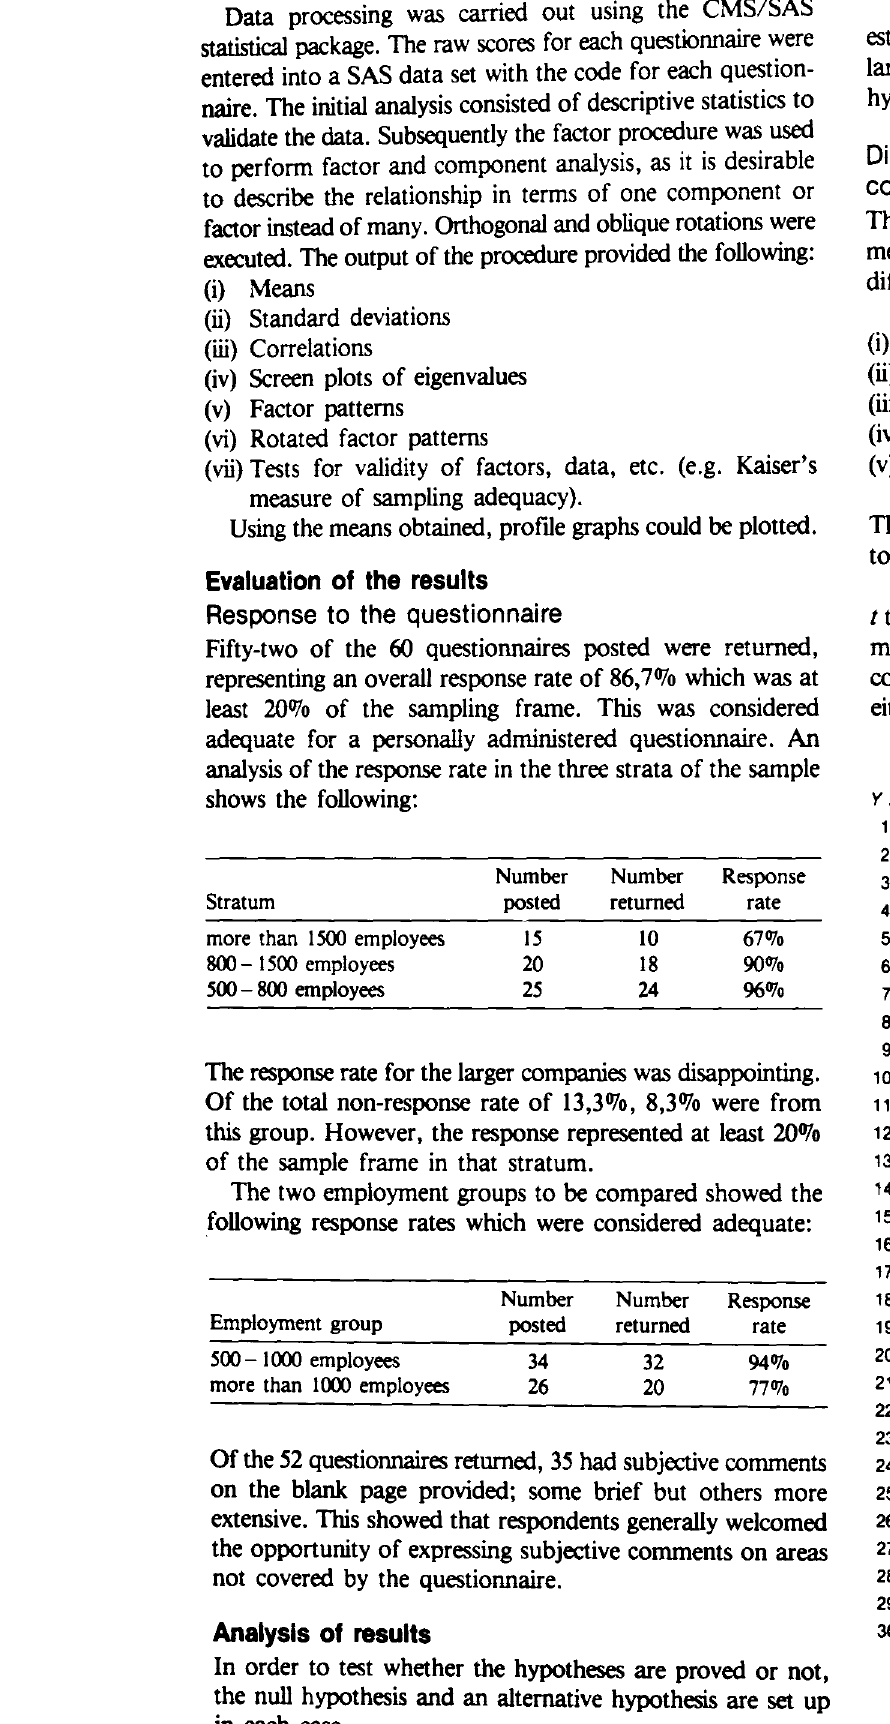
Figure 1 Profile graph of mean of all consultancies against mean of